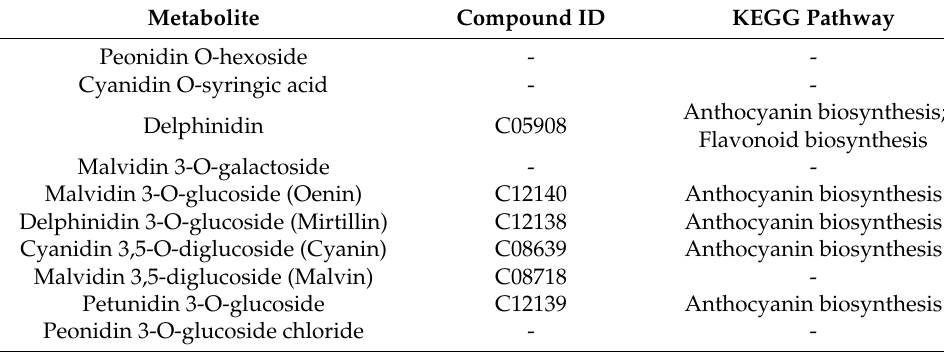
Table 5. Annotation of differential metabolites in